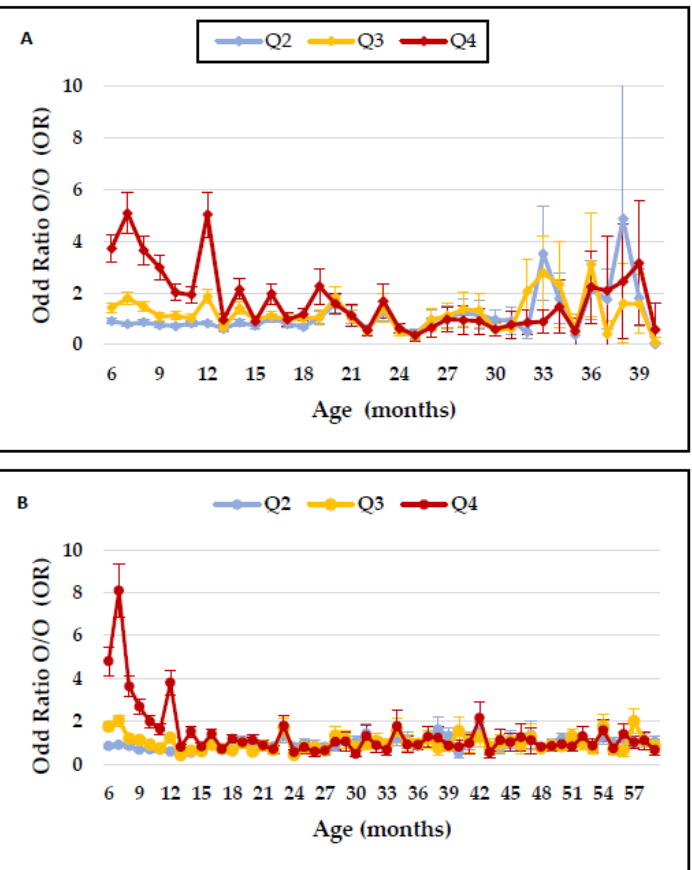
Figure 2. Maternal exposure in different quartiles of PM 2.5 on O/O rate. ( A ): intrauterine exposure; ( B ): extrauterine